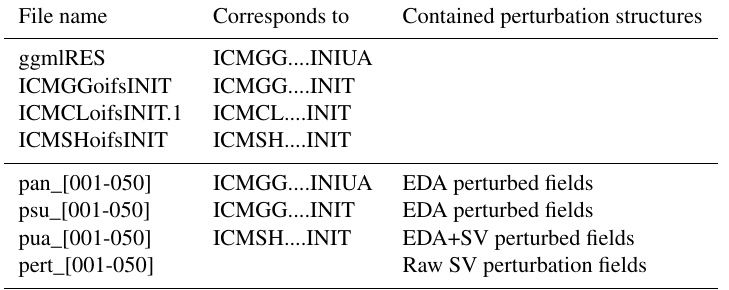
Table 3. Types of initial states that can be constructed from the dataset. Type Files needed Required file operations Control/deterministic ggmlRES Use as ICMGG....INIUA forecast ICMGGoifsINIT Use as ICMGG....INIT